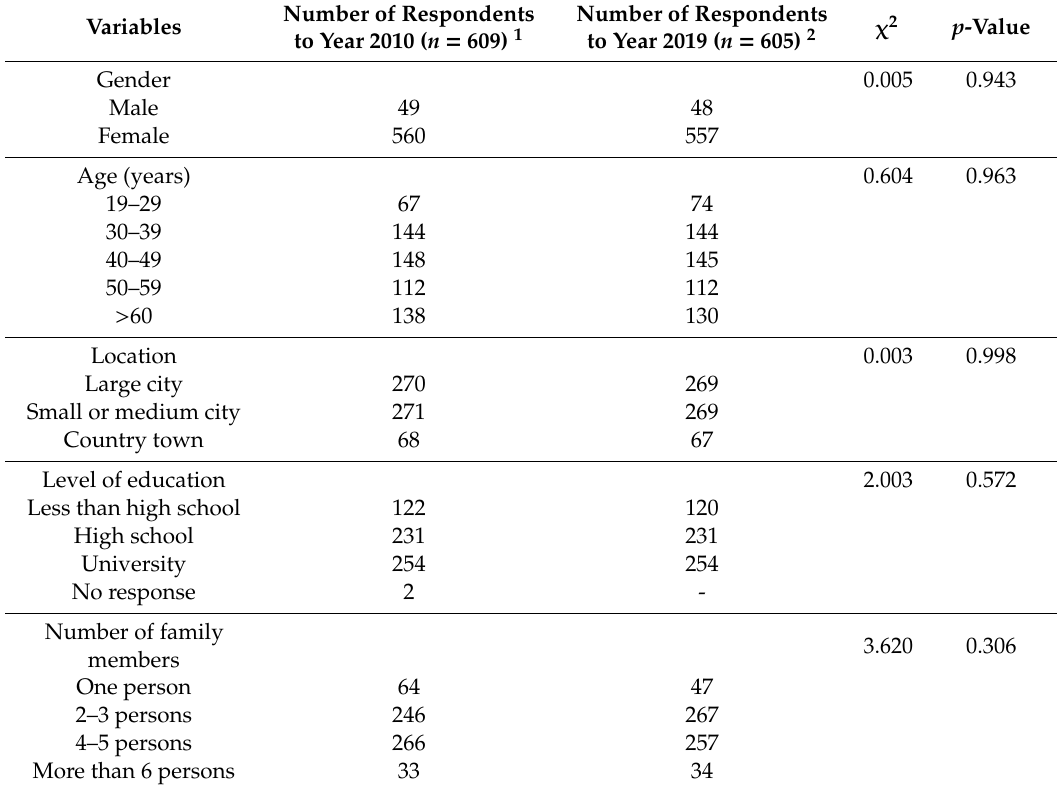
Sociodemographic characteristics of the respondents and chi-square test results for each